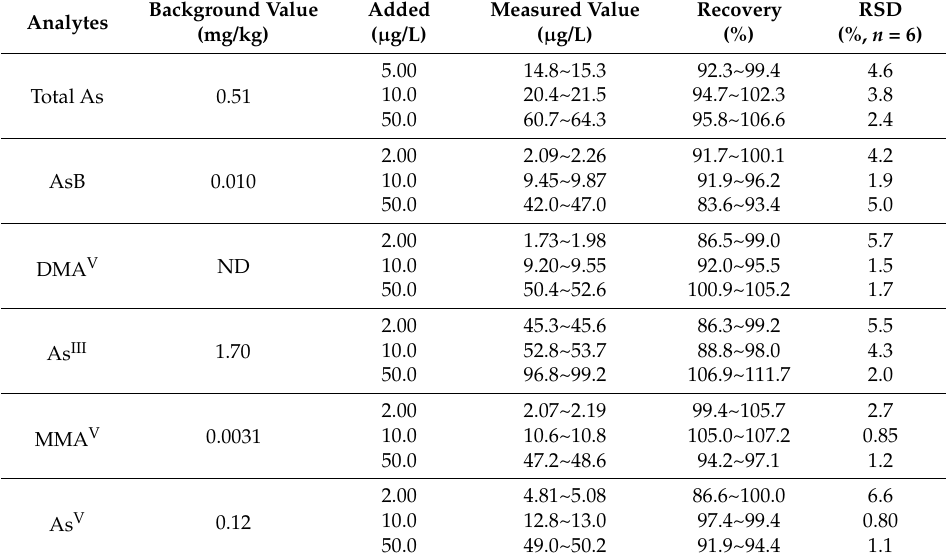
Table 2. Recovery and precision of the methods.